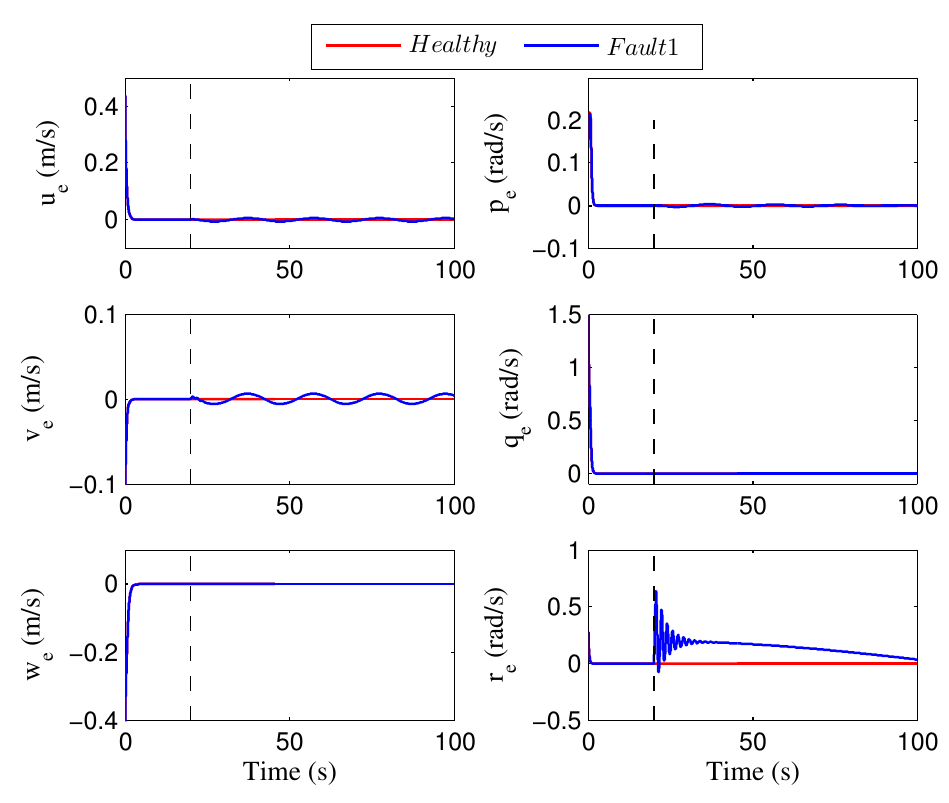
Figure 6. The velocity and angular velocity errors with fault 1.